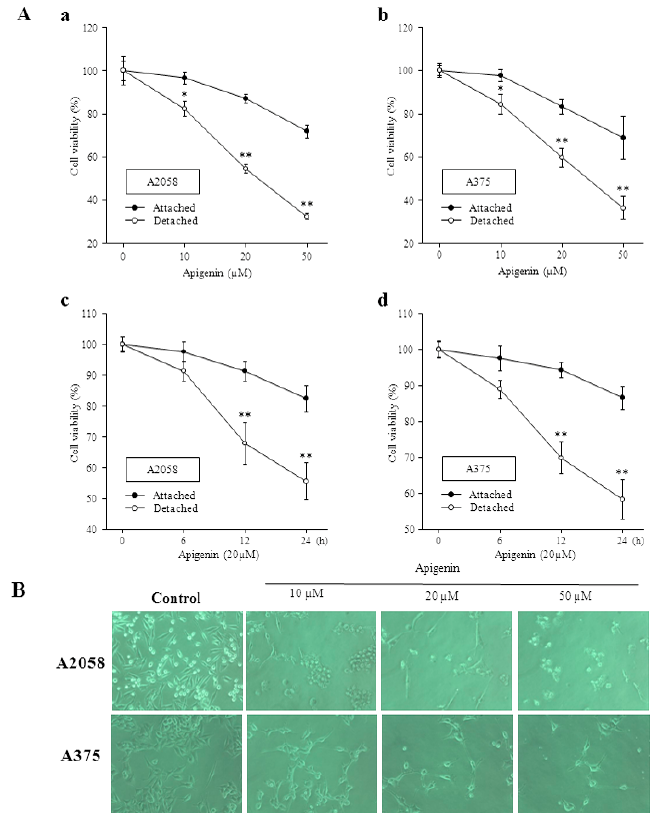
Figure 1. Apigenin inhibits proliferation and viability of human melanoma cells and induces